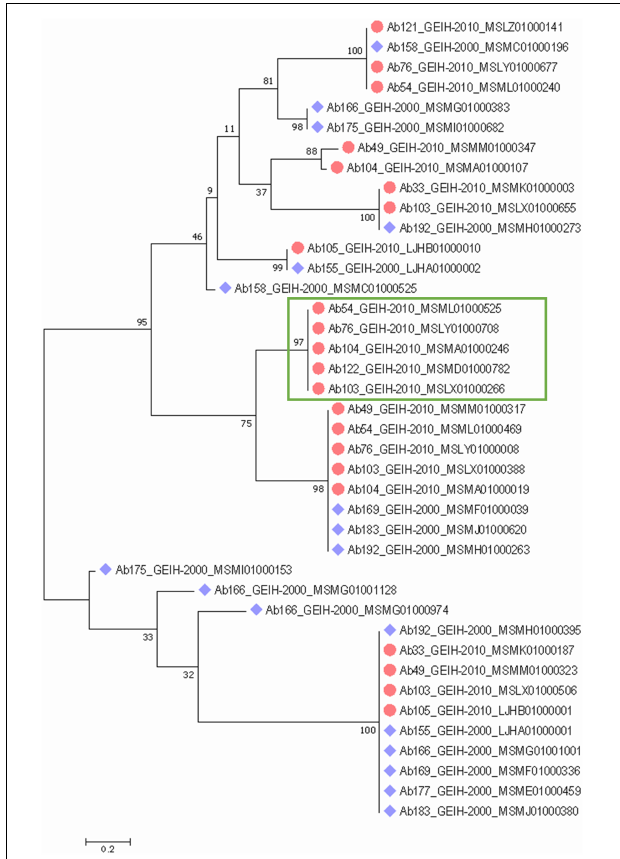
FIGURE 4 | Phylogenetic classification of CRISPR arrays detected in 18 genomes of A. baumannii ST-2 clinical strains through a maximum-likelihood tree with suggested model by MEGA analysis Tamura 3-parameter with uniform rates among sites and a bootstrap of 100. Blue rhomboid indicates that strain belongs to 2000 collection. Red circles to 2010 collection. Green rectangle indicates five CRISPR arrays only detected in 2010